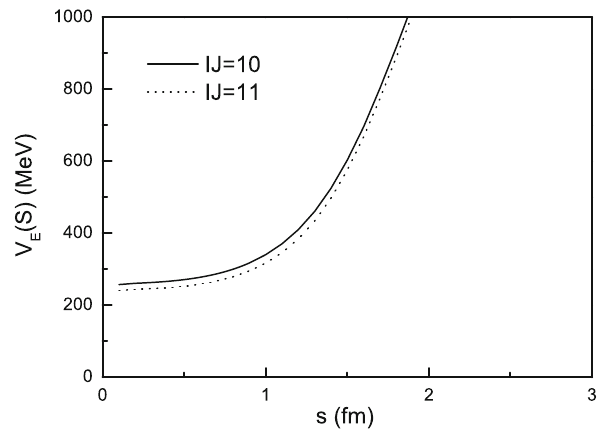
Fig. 3 The effective potentials as a function of the distance between the diquark ( qq ) and antidiquark ( ¯ q ¯ q ) for the I J = 10 and I J = 11 states of ud ¯ s ¯